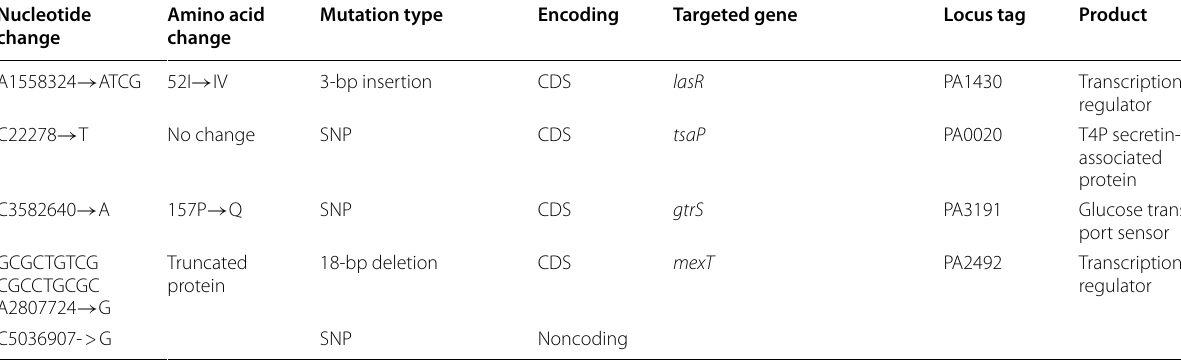
Whole-genome re-sequencing (WGS) was performed with the PAO1-z strain. Short reads were mapped to the reference PAO1 genome (NC_002516.2). Genome mutations were identified relative to the PAO1-u strain